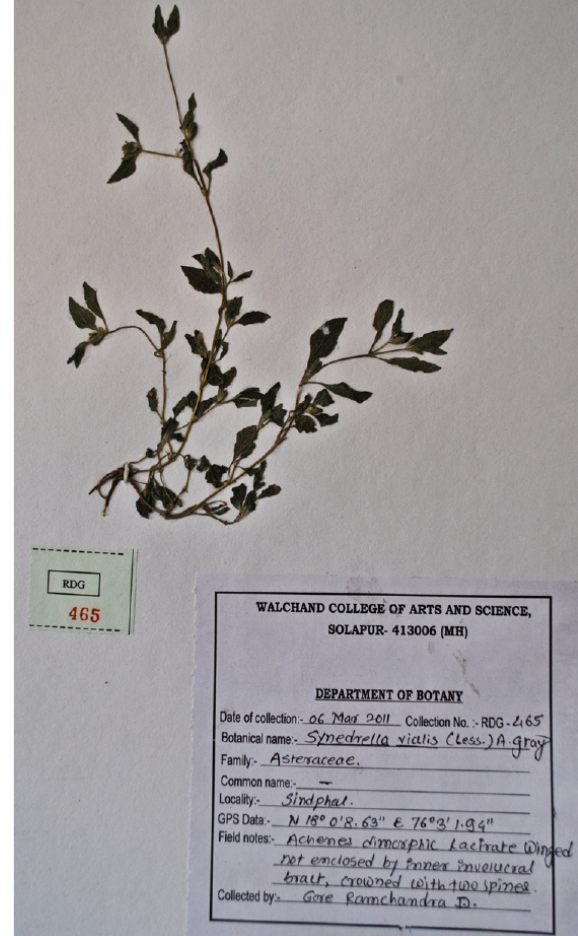
Image 22. Synedrella